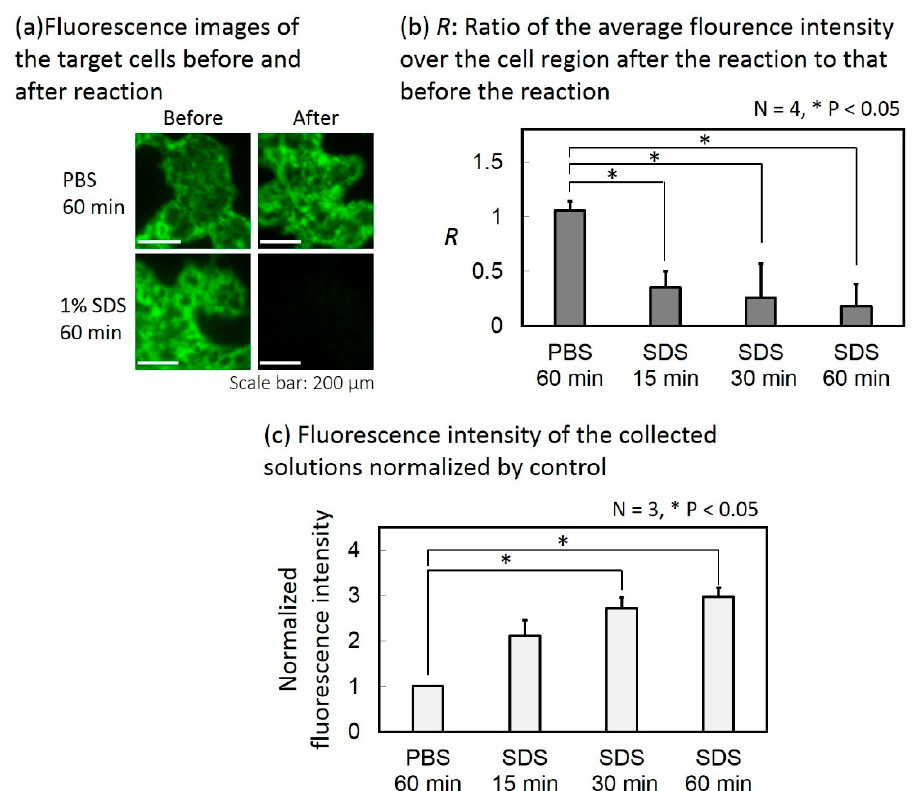
Figure 9. Collection of the target-specific antibodies (Abs) attached on the target cells. ( a ) Fluorescence images of target cells before and after the reaction. ( b ) Ratio of the average fluorescence intensity over the cell region after the reaction to that before the reaction. ( c ) Fluorescence intensities of the collected solutions normalized by control.